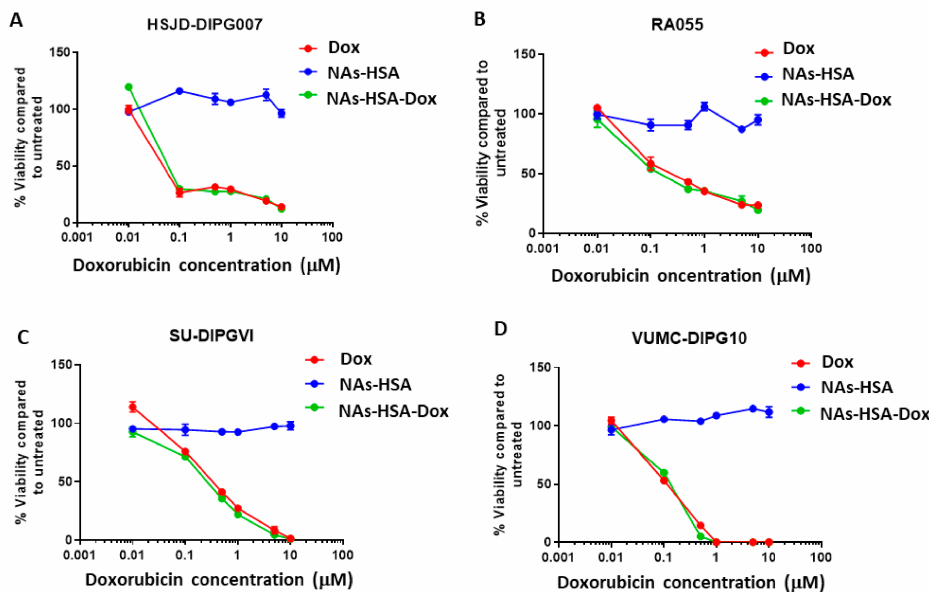
Figure 2. Gold nanoparticles loaded with doxorubicin reduce cell proliferation in DIPG neurospheres; ( A – C ) Cytotoxic efficacy of doxorubicin (Dox), Gold nanoparticles (NAs-HSA) and NAs-HSA loaded with doxorubicin (NAs-HSA-Dox) for 72 h in H3K27M DIPG cultures HSJD-DIPG007, RA055 and SU-DIPG-VI; ( D ) Cytotoxic efficacy of Dox, NAs-HSA and NAs-HSA-Dox for 72 h in H3K27wt DIPG culture VUMC-DIPG-10. Alamar blue assay was used to assess viability, presented as % viability compared to untreated cells. Experiment was performed twice, N = 8 each